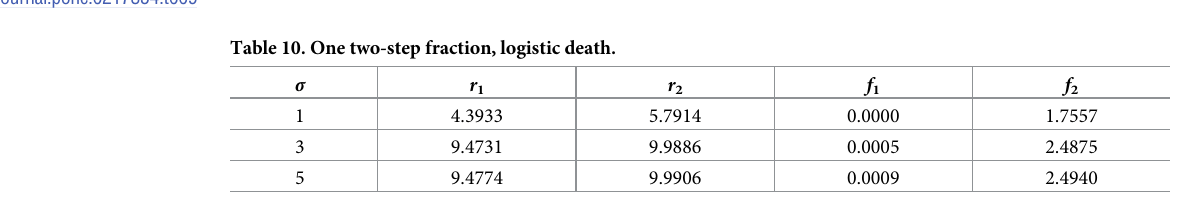
Optimal two-step profile for one fraction of radiation with logistic growth and death. σ is the standard deviation of the initial Gaussian tumour cell density, which starts with 10 7 total cells. r 1 , r 2 , f 1 , and f 2 are the radii and strengths of the steps in the cytotoxic radiation profiles. N ( t + dt ) is the final tumour cell number at the end of